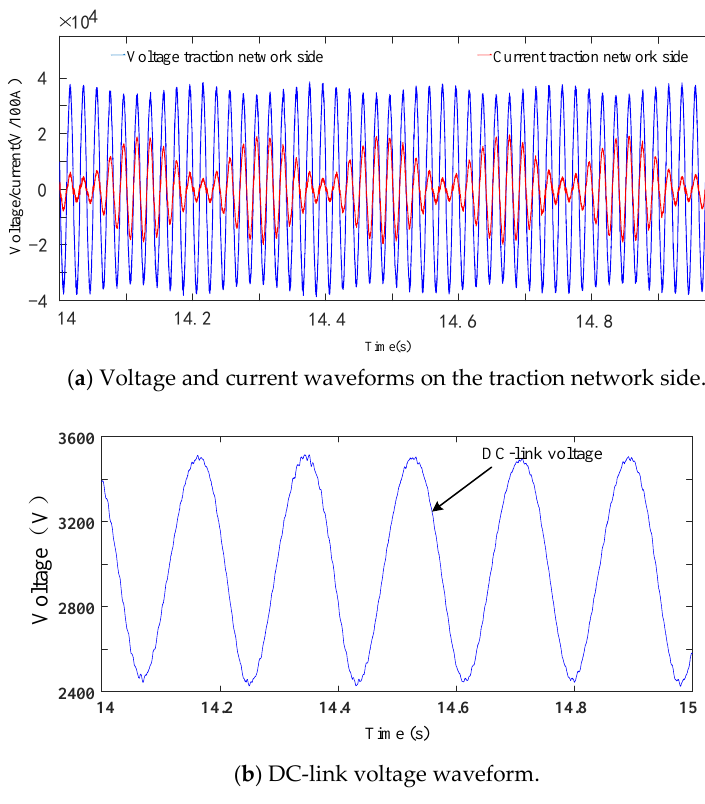
Figure 16. Voltage and current waveforms with six EMUs accessed based on the PI controller.